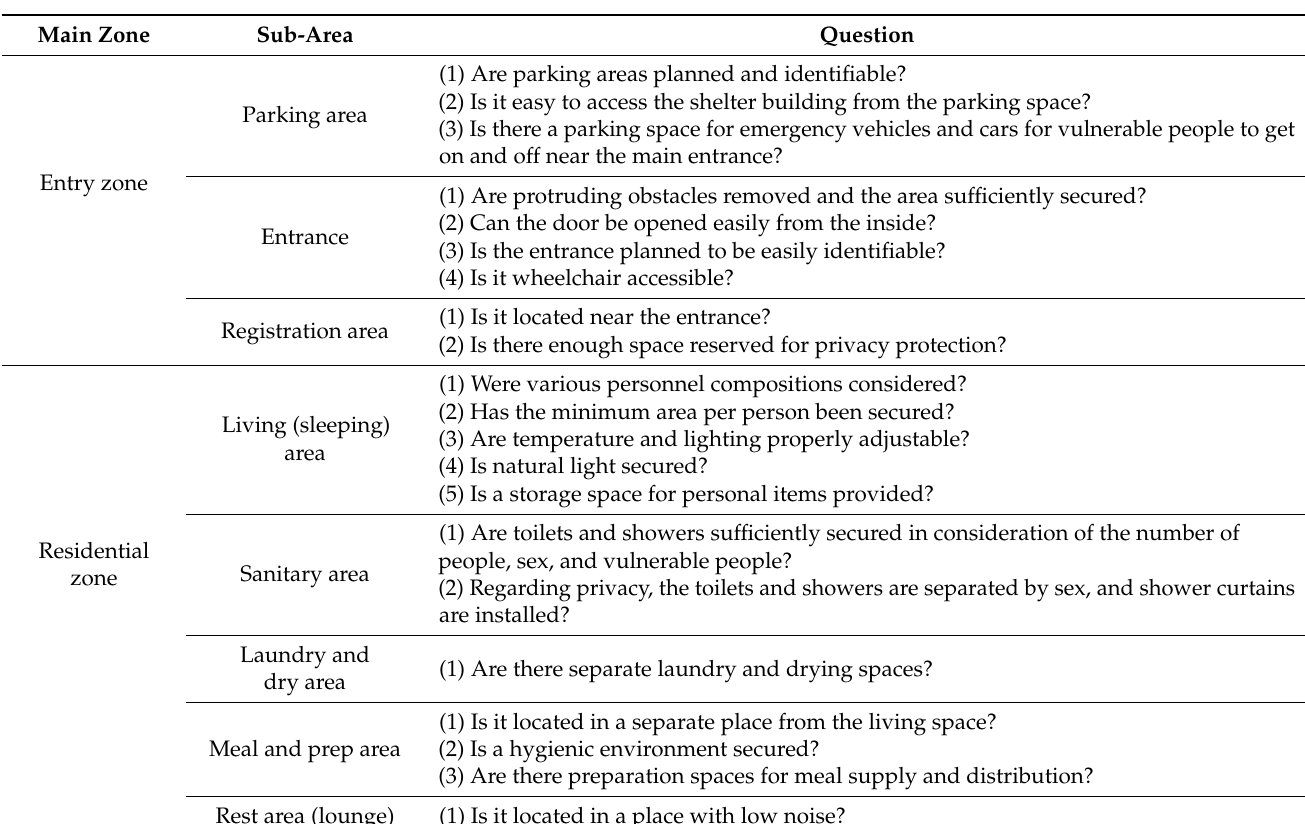
Table 3. Semi-structured questionnaire